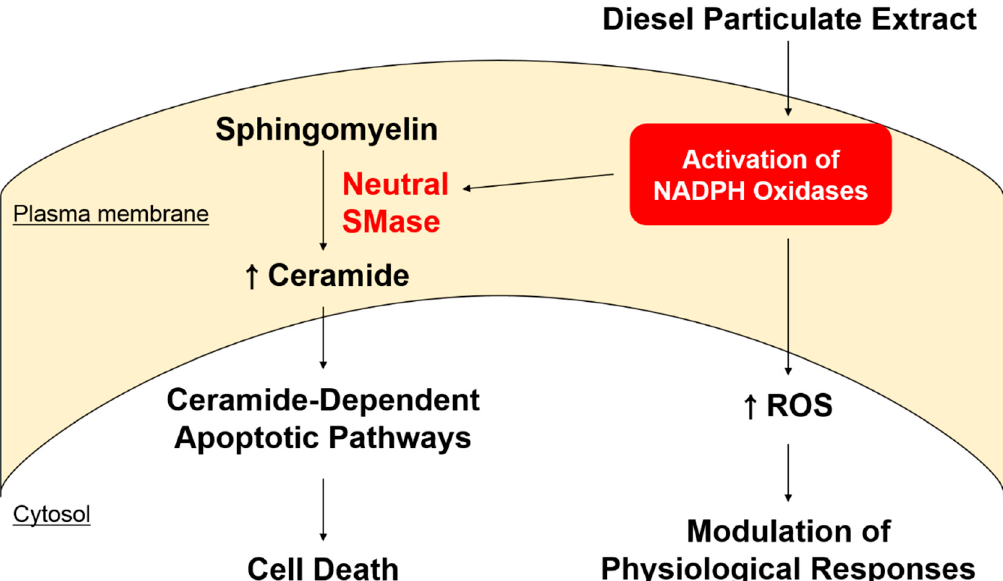
Figure 5. Proposed mechanism for DPE-mediated induction of KC apoptosis. DPE-mediated activation of NOXs triggers activation of neutral SMase, in turn inducing KC apoptosis through increased ceramide production, rather than through a ROS-dependent mechanism.